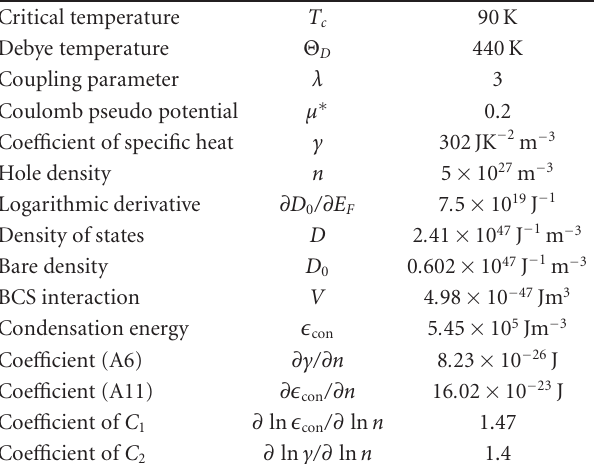
Table 1: Material parameters for